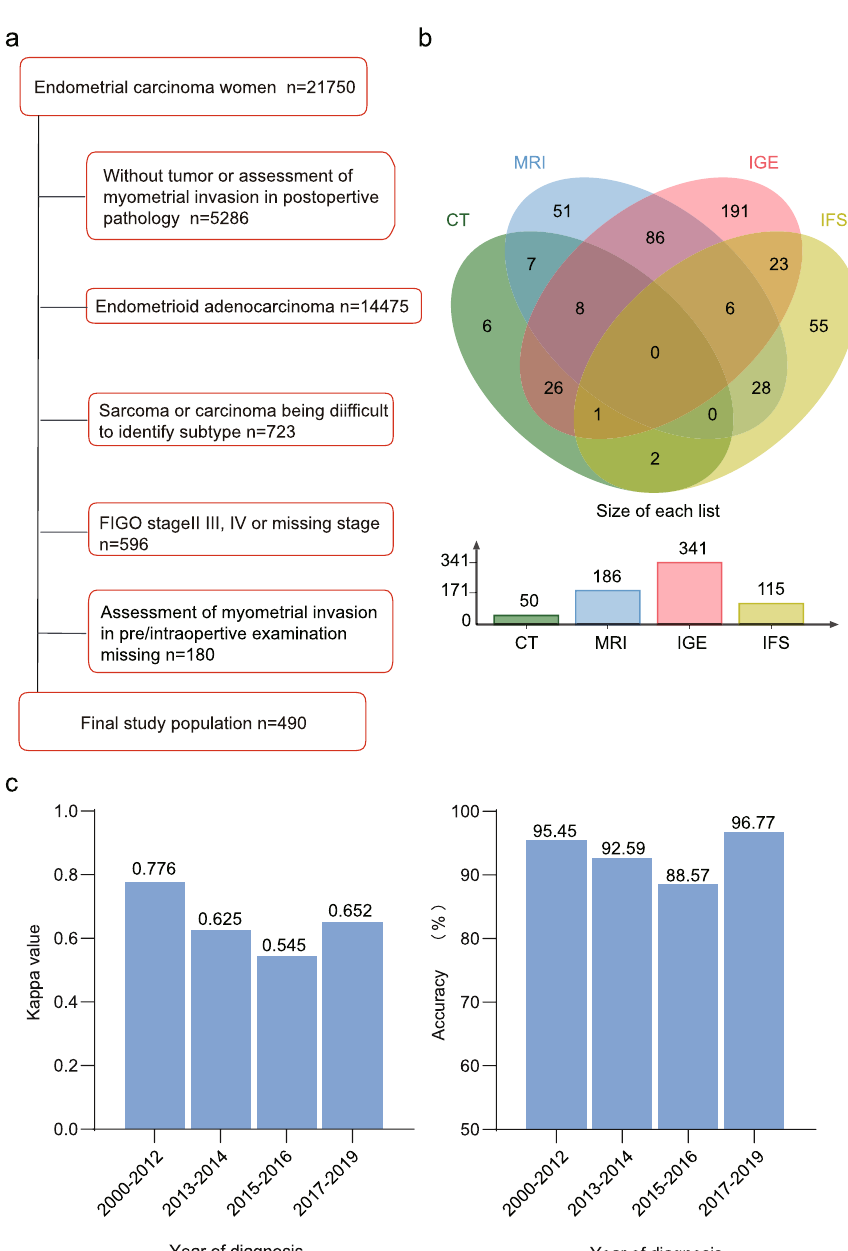
Fig. 1 a Flow of participants, using a diagram; b Grouping of the final study population through the Wayne chart way (preoperative CT, preoperative MRI, intraoperative gross examination, and intraoperative frozen section); c The Kappa value and accuracy of intraoperative frozen section compared with the final histopathology by year of